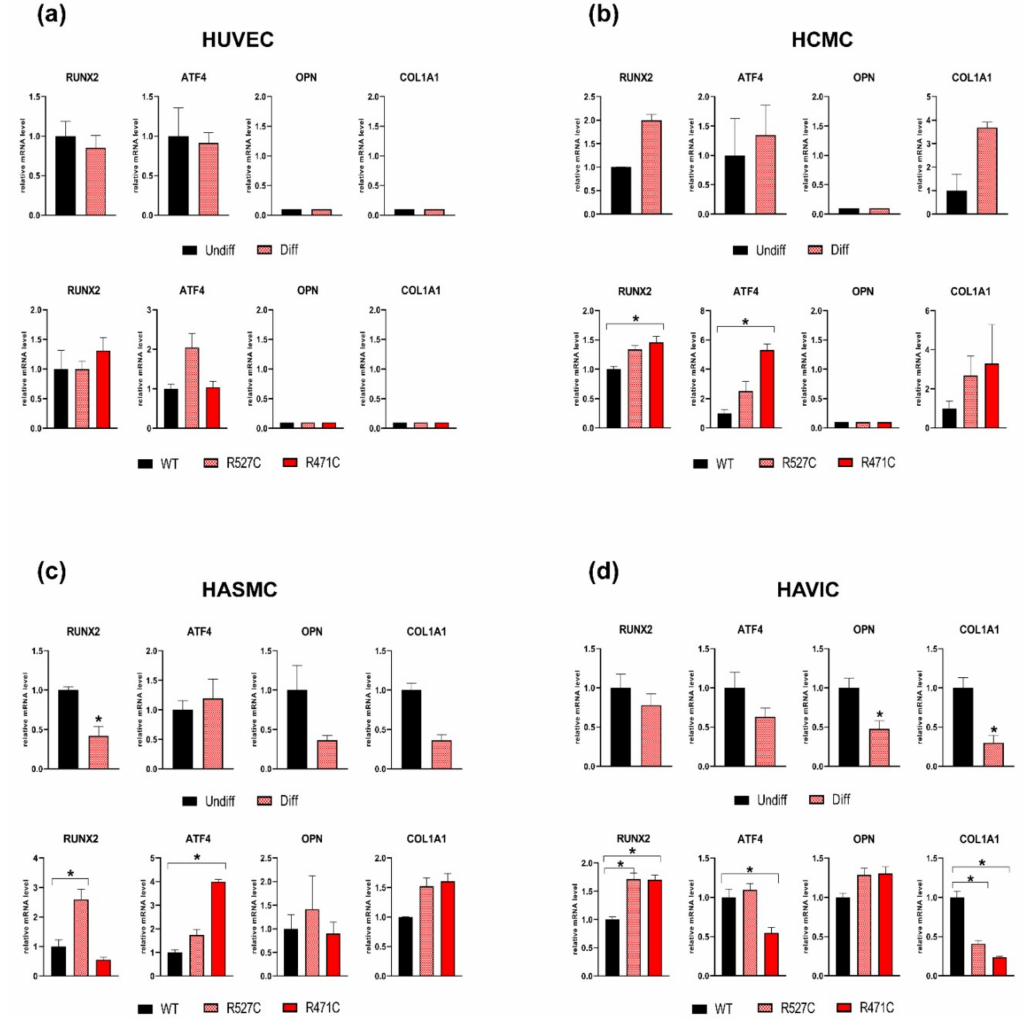
Figure 3. The effect of LMNA R527C and LMNA R471C mutations on the osteogenic differentiation process of human mesenchymal cells. Cells were differentiated in osteogenic direction for 3 days. Upper panel for each type of cell: HUVEC ( a ), HCMC ( b ), HASMC ( c ) and HAVIC ( d ) represent the analysis of osteogenic marker expression by qPCR in undifferentiated cells (Undiff) and after 3 days of osteogenic differentiation (Diff). Lower panel for each type of cell (a, b, c, d) represents analysis of osteogenic marker expression by qPCR in cells transduced with lentivirus bearing either LMNA WT (WT) or LMNA R527C /LMNA R471C (R527C/R471C). The results are represented as mean ± SD; * p <